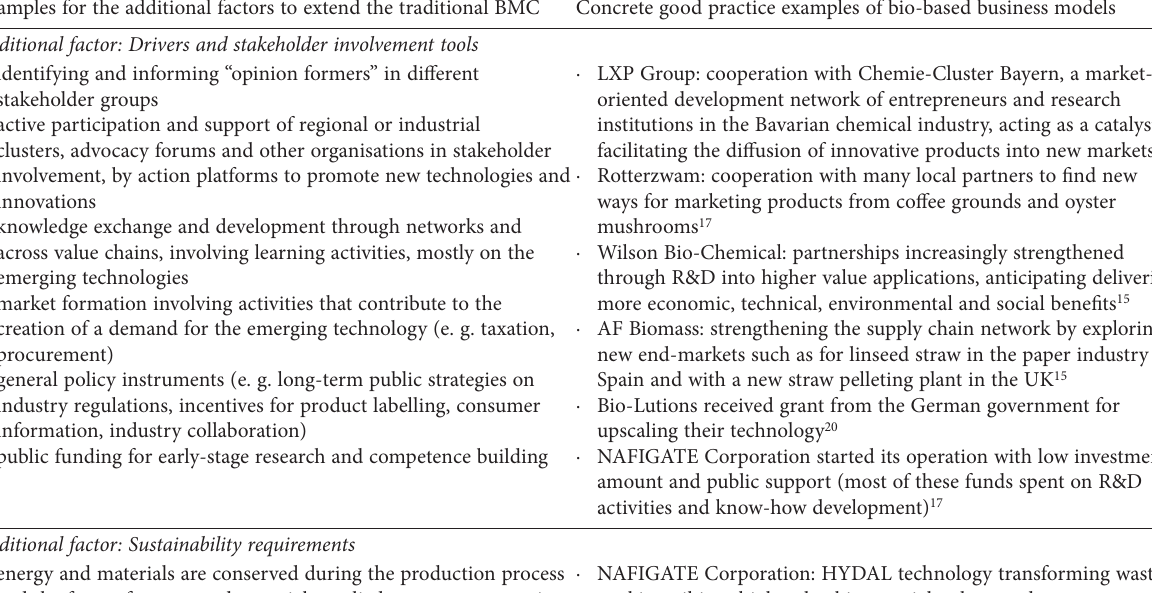
Table 2. Examples for additional factors to extend the traditional BMC, and good practices identified in bio-based business models for these